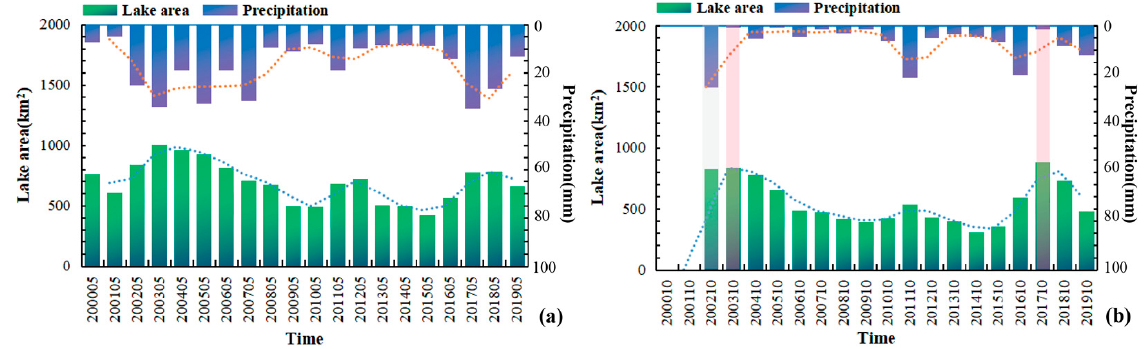
Figure 12. Precipitation and lake area changes from 2000 to 2019 ( a ): wet season; ( b ): dry season.